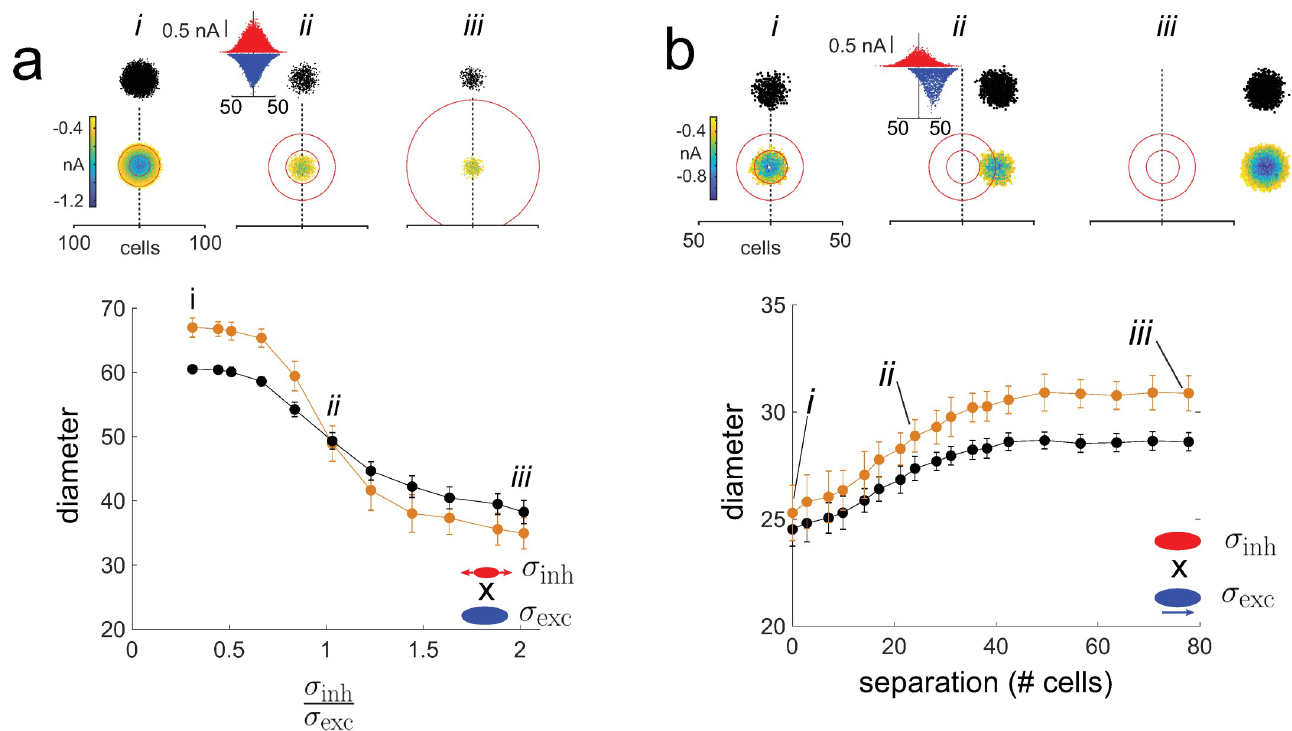
Fig 7. Test of multiplication. a, top, i-iii activated areas and synaptic fields evoked with excitatory ( σ exc = 20) and inhibitory ( σ inh = 2 − 45) inputs. The spatial extent of the inhibition is demarcated by the red circles (inner circle: 1 σ ; outer: 2 σ ). Inset in ii shows an example of excitatory (blue) and inhibitory (red) inh inh synaptic current profiles. bottom , plot of activated area (black) and synaptic field (orange) vs s inh . b , Same as in a except that the excitatory input ( σ exc = 10) was s exc shifted systematically to the right of inhibition ( σ = 10). bottom , Diameters of activated area (black) and synaptic field (orange) plotted against separation inh between excitatory and inhibitory synaptic fields.